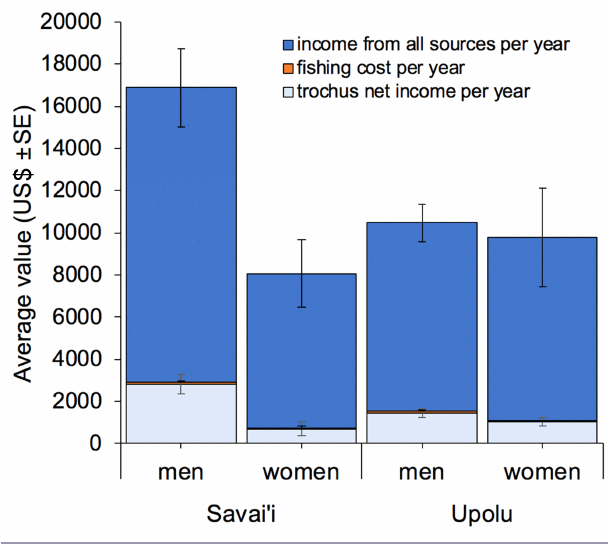
Fig. 4 . Average value (US$ ± s.e.) of fishing cost per year, trochus ( Rochia nilotica ) net income per year, and income from all sources per year for men and women that sell trochus on Savai’i and Upolu